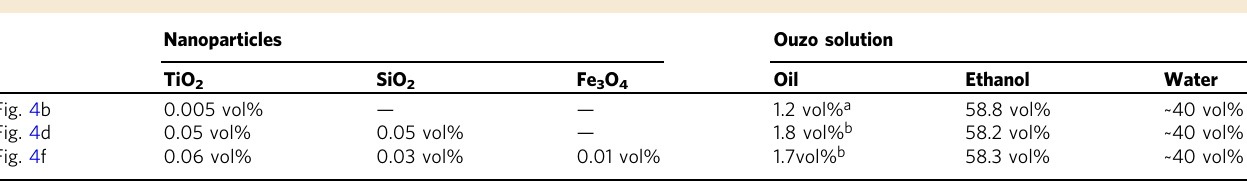
a Anise oil (Sigma-Aldrich; Anise oil) b Trans-anethole oil (Sigma-Aldrich; trans-anethole, ≥ 99.8%)